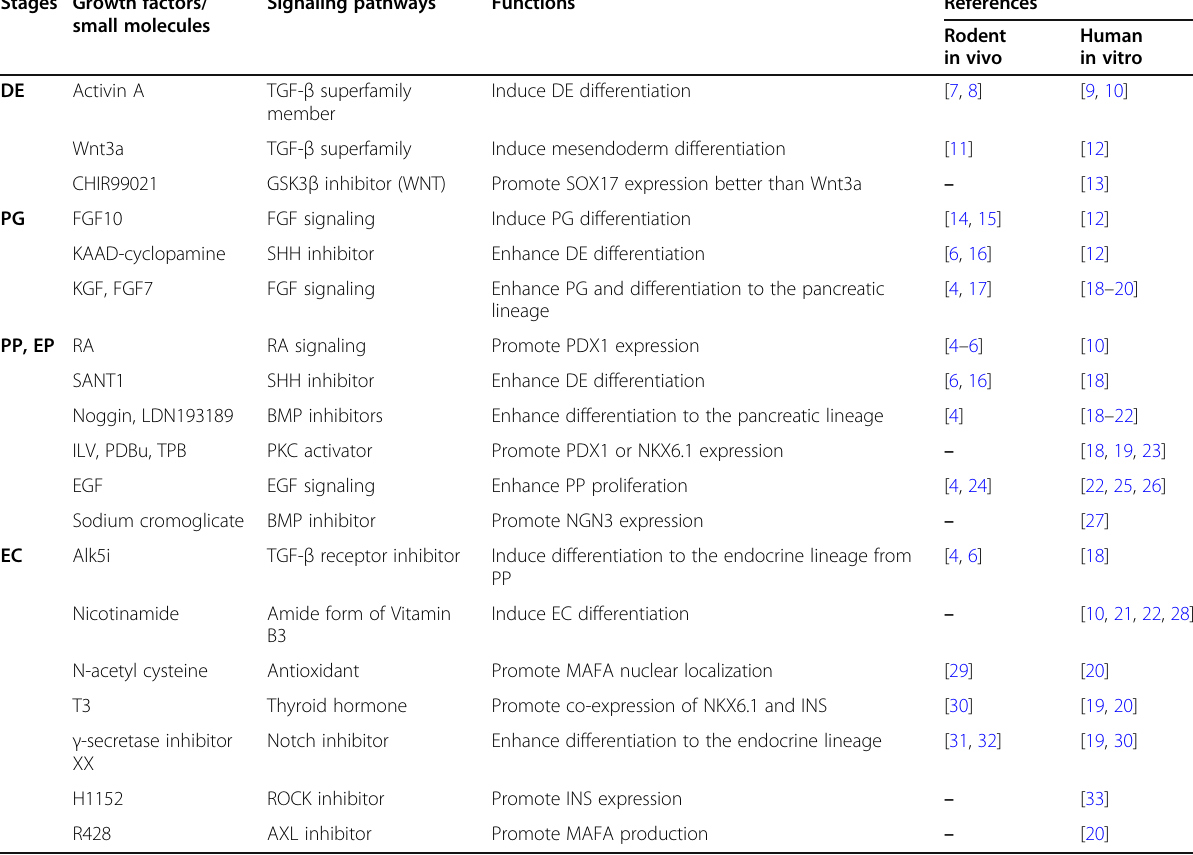
Table 1 A list of growth factors and small molecules adopted in the in vitro differentiation procedures Stages Growth factors/ small molecules